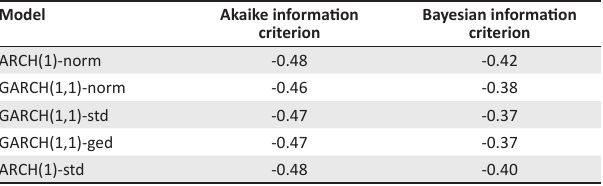
TABLE 2: Estimated generalised autoregressive conditional heteroscedasticity models with Akaike information criterion and Bayesian information criterion